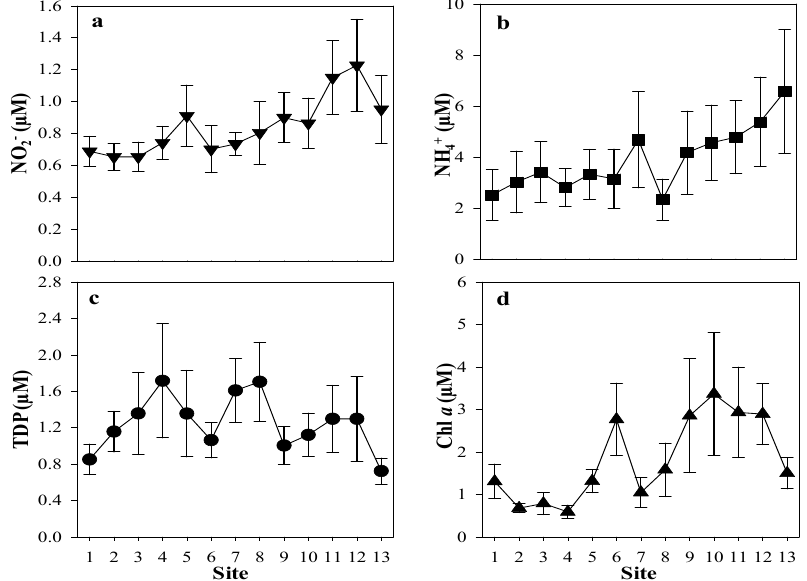
Figure 3. Spatial variations of mean concentrations ( ± SE) of NO 2 − ( a ), NH 4 + ( b ), TDP ( c ) and Chl. a ( d ) in Maryland Coastal Bays based on measurements obtained during 10 months from July 2014 to October 2017.